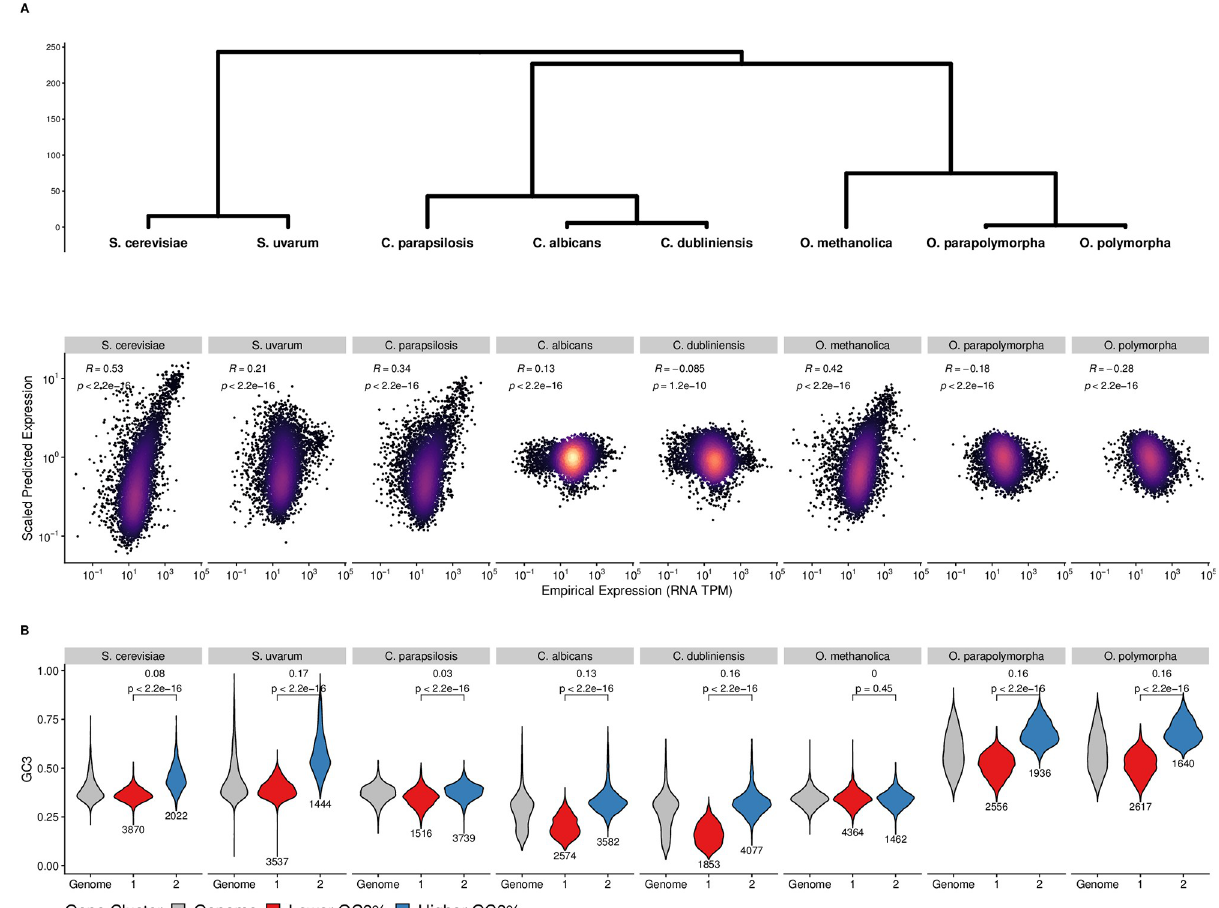
Fig 1. Ability to detect selection on codon usage varies between closely-related species. (A) Correlations between empirical mRNA abundances and predicted gene expression values for all genes from ROC-SEMPPR across 8 Saccharomycotina species. Phylogenetic relationships between species indicate relatedness between species, with branch lengths units in millions of years. (B) Distribution of GC3% for the entire genome (grey), as well as for the distributions within each of the clusters determined by the CLARA clustering. We denote the cluster with the lower median GC3% as the Lower GC3% cluster (red) and the cluster with the higher median GC3% as the Higher GC3% cluster (blue). Brackets indicate the difference in medians between the lower and higher GC3% clusters, as well as the p-value from a Kolmogorov-Smirnov test comparing the distribution of GC3% between the two